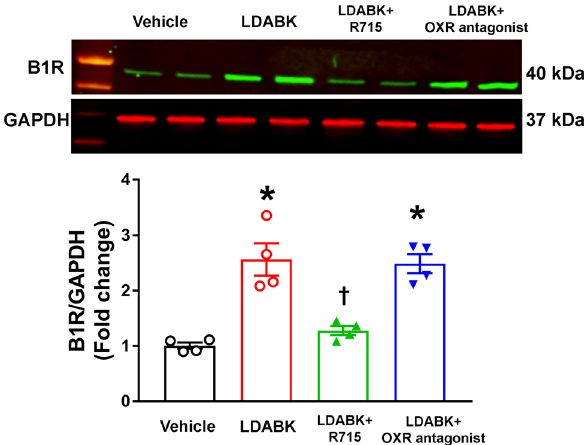
Figure 6. Orexin receptor antagonist fails to prevent B1R activation. Primary hypothalamic neurons stimulated with specific B1R agonist LDABK (300 nM) showed significant increase in B1R protein expression as measured and quantified by western blot analysis. Pretreatment with R715, a B1R specific antagonist, blunted this upregulation of B1R protein expression by LDABK. However, pretreatment with a dual orexin